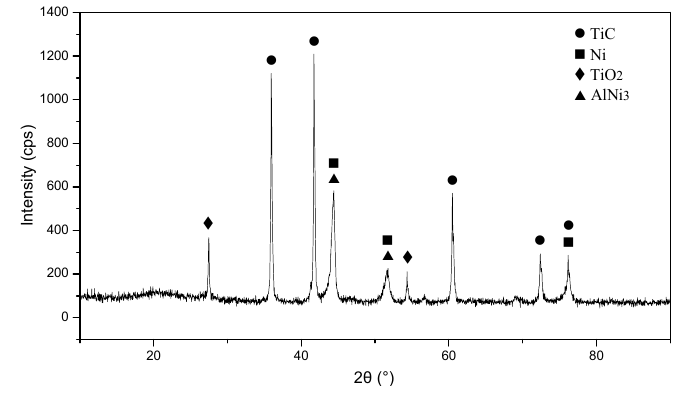
Figure 8. XRD pattern of the original coating after the immersion test.